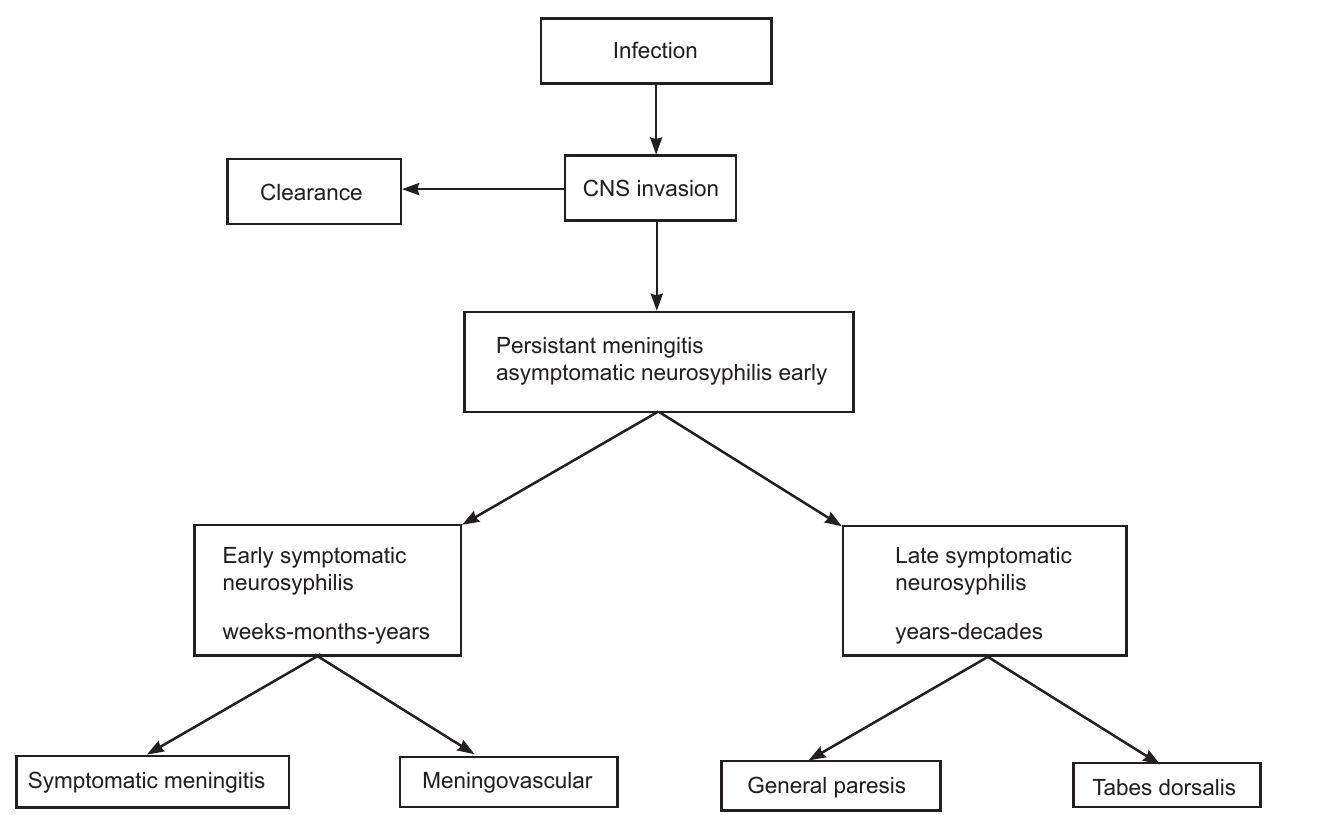
Figure. Natural history of neurosyphilis. Neuro-invasion occurs in at least 40% of individuals. Clearance occurs in about 70% of individuals. The remaining 30% of patients have persistent central nervous system (CNS) infection, also called asymptomatic neurosyphilis. In the pre- penicillin era, about 20% of individuals with asymptomatic neurosyphilis developed one of the symptomatic forms of neurosyphilis. In the penicillin era, the early forms (eg, symptomatic meningitis, meningovasculitis) are more common than the late forms (e.g., dementia and tabes dorsalis). Reprinted with permission from Marra CM.